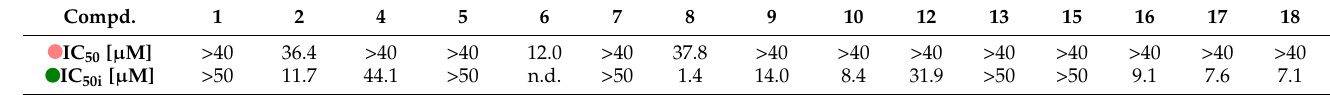
Table 3. Cytotoxicity and anti-HIV-1 activity of the tested compounds a . Compd. a HEK 293 cells were grown in the presence or absence of tested compounds at a concentration ranging from 5 to 40 μ M. The viability of the cells was determined by Resazurin assay 48 h later ( ). To determine the effect of the compounds on HIV-1 infectivity ( ), HEK 293 cells were transfected with the lentiviral vectors and treated with the tested compounds. The cells producing HIV-1 particles in the presence or absence of DMSO (at a final concentration of 1%) were used as controls. At 48 h post-transfection, the content of HIV-1 capsid (CA) protein from the culture media was quantified by ELISA and normalized amounts of VSV-G pseudotyped HIV-1 viruses were used to infect fresh HEK 293 cells. HIV-1